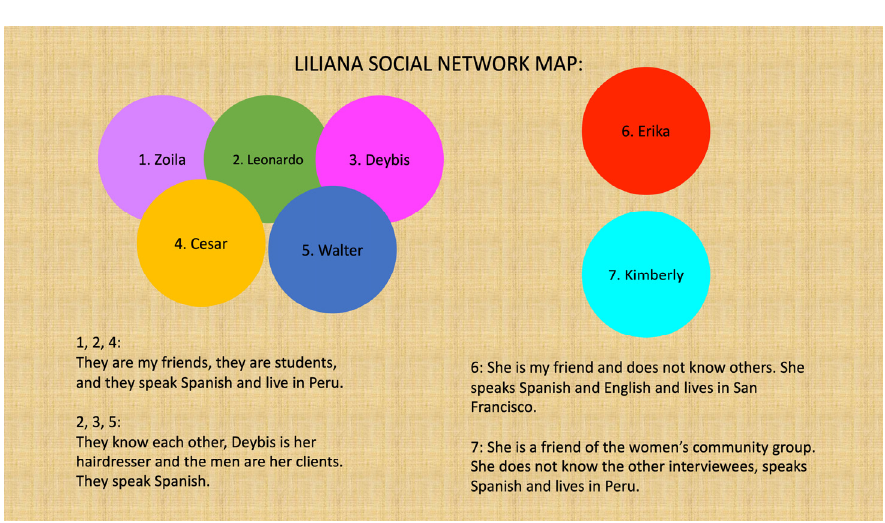
Figure 3. Depiction of a learner’s social network where the learner is not in the image, and people are grouped by their relationships with each other, with two (6 and 7) outside of the main cluster. Names have been changed to preserve confidentiality.